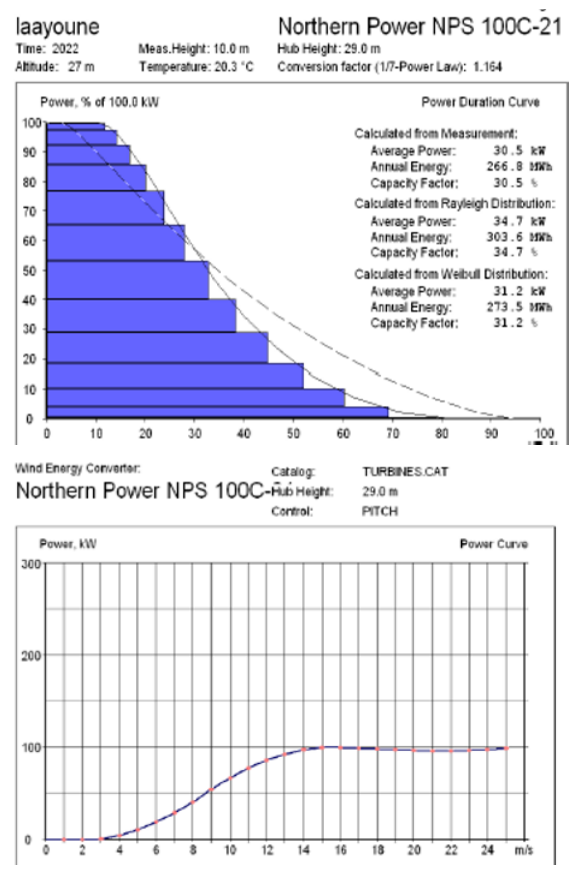
Fig. 7. Annual production for the Northem Power NPS 21- 100KW calculated by ALWIN.